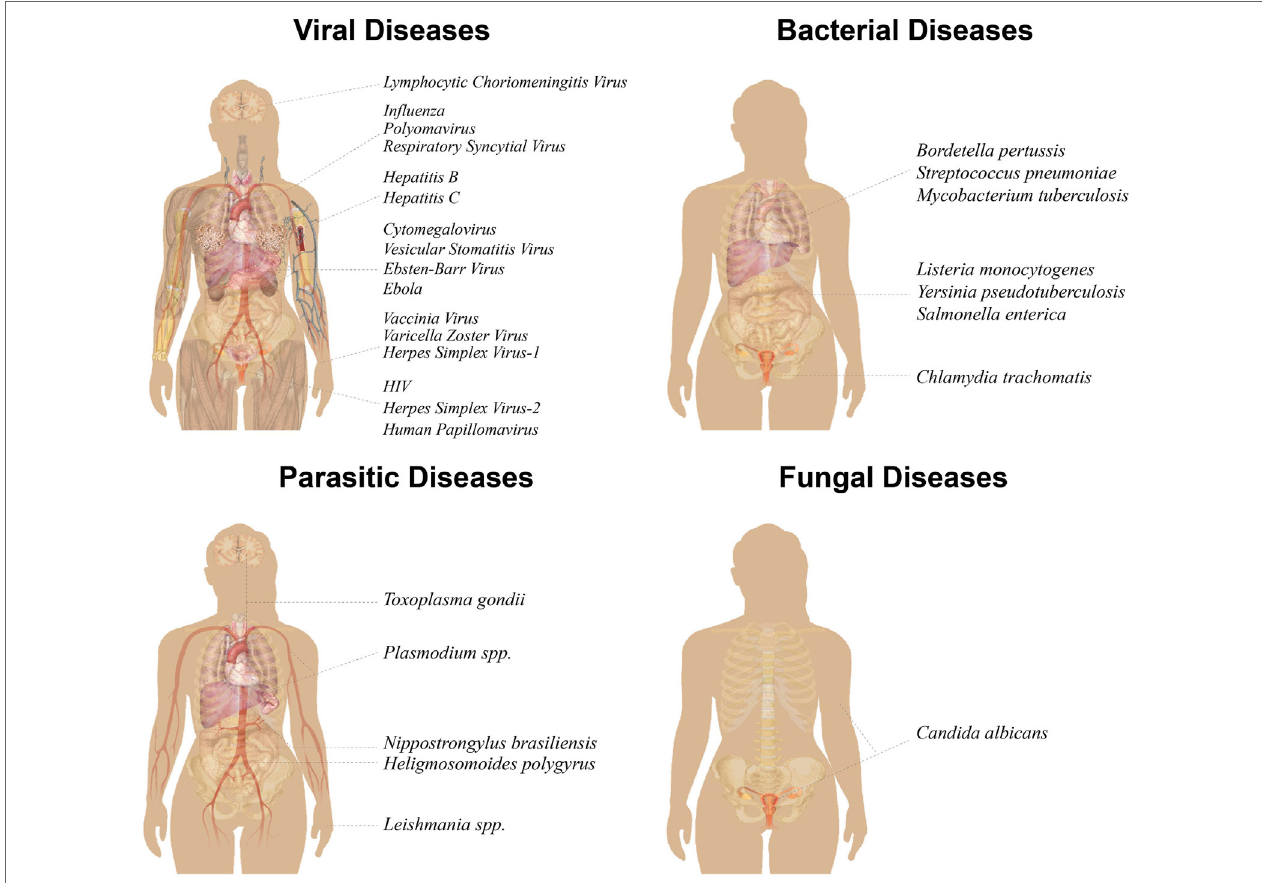
FiguRe 2 | Illustration of human-relevant diseases for which a role of T RM has been reported. T RM have been studied in 16 viral diseases (top left), seven bacterial diseases (top right), five parasitic diseases (bottom left), and one fungal disease (bottom right). Pathogens have been grouped according to organs or organ systems that have been studied in the context of T RM , including the respiratory, gastrointestinal, and urogenital tracts, as well as brain, skin, liver, lymphatics, and circulation. Nippostrongylus brasiliensis and Heligmosomoides polygyrus are mouse pathogens for human Necator americanus and gastrointestinal helminth infections, respectively. Image modified from